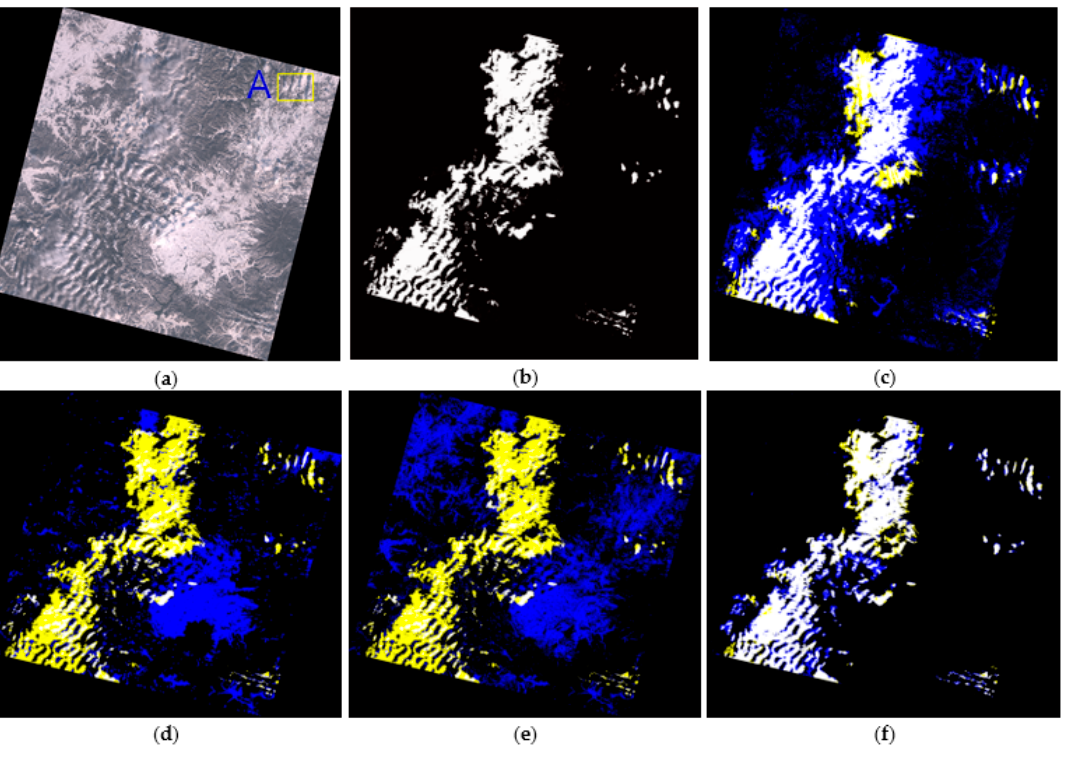
Figure 4. Comparison of cloud detection effects of different algorithms (the yellow area in the figure indicates the missed detection pixels and the blue area indicates the wrong detection pixels, the letter A represents the subregion of the whole image, we will discuss different algorithms performance in this area). ( a ) True color Landsat8 images. ( b ) ground truth. ( c ) Fmask. ( d ) MFC. ( e ) CSD-SI. ( f ) ours.